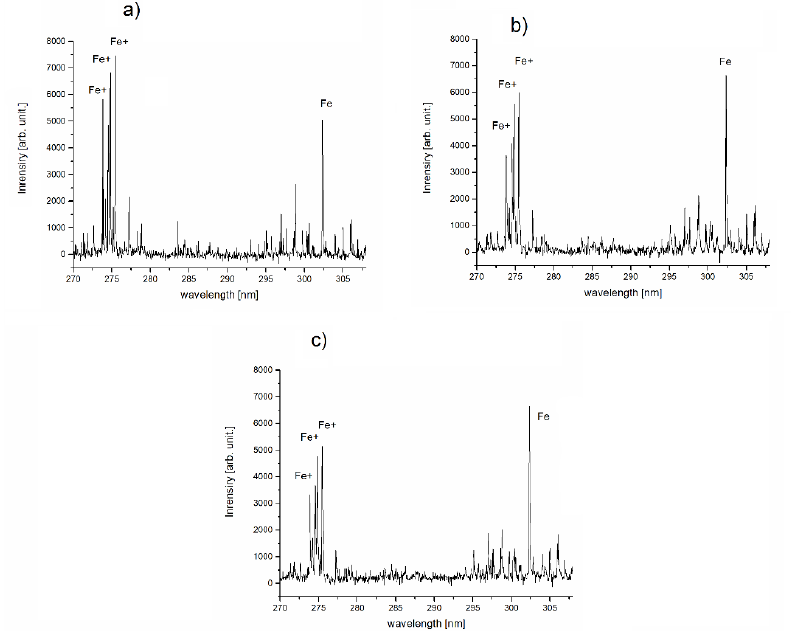
Figure 5. Emission spectra with Fe and Fe + spectral lines of HiPIMS plasma for different mass flow rates of H 2 S gas Q H2S ( a ) for H 2 S gas flow Q H2S = 0 sccm, ( b ) for H 2 S gas flow Q H2S = 7.8 sccm, ( c ) for H 2 S gas flow Q H2S = 19 sccm.